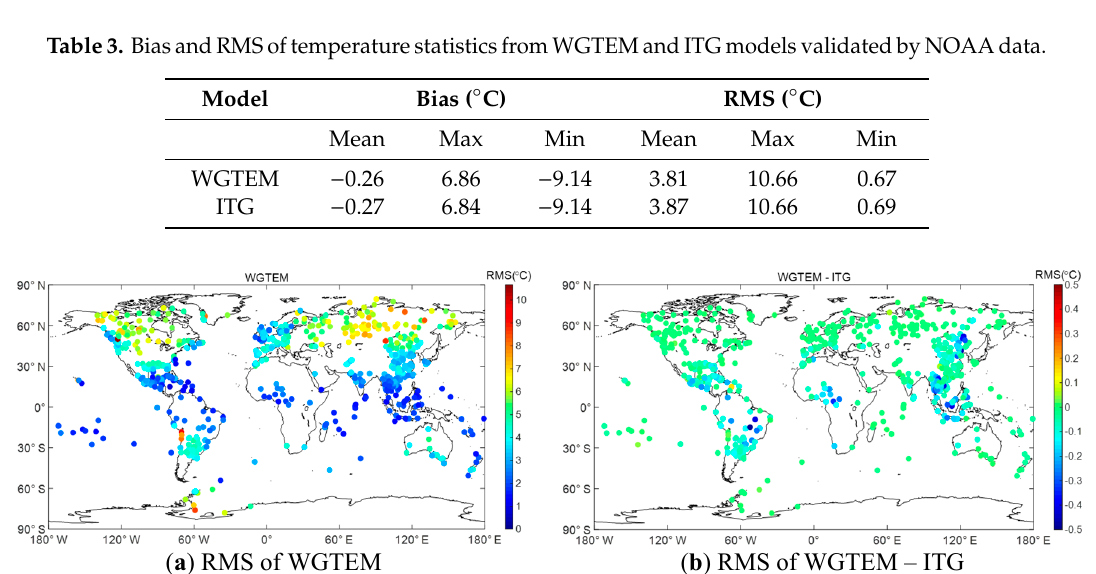
Figure 4. Temperature series in 2012 from NOAA, GPT2 model, WGTEM, and Improved Tropospheric Grid (ITG) model at two International GNSS Service (IGS) stations.